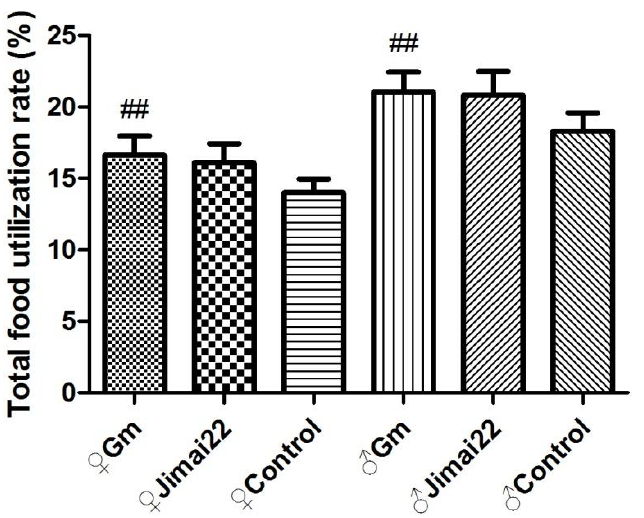
Figure 4. Total food consumption of females and males during 13 weeks.